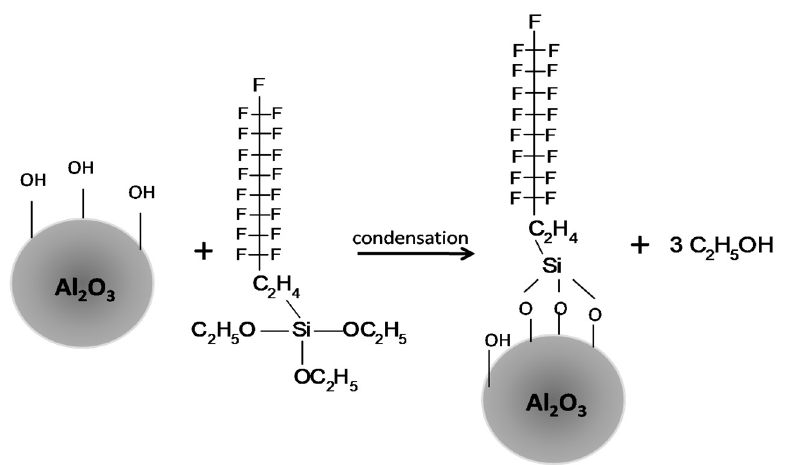
Figure 3. The mechanism of Al 2 O 3 surface functionalization where condensation reaction between Al 2 O 3 and FAS yields functionalized Al 2 O 3 . Adapted with permission from [19]; Copyright 2013 Elsevier.